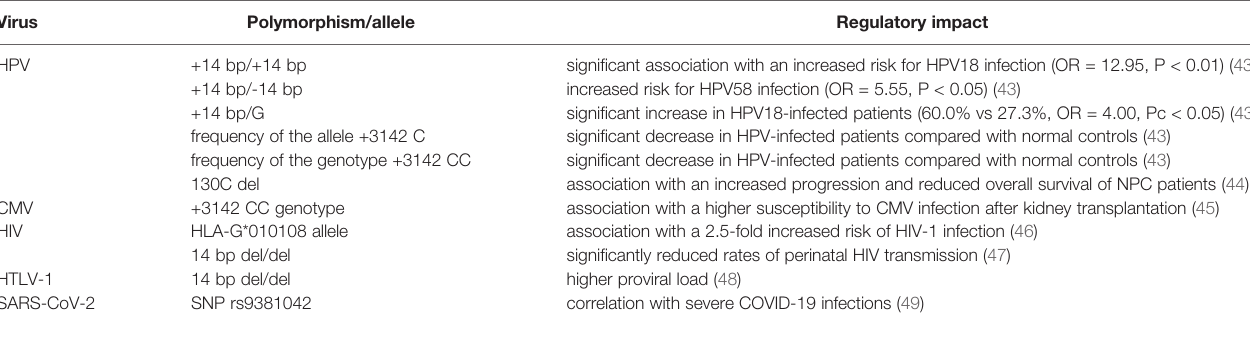
TABLE 1 | Impact of HLA-G polymorphisms on viral infections and virus-mediated diseases.